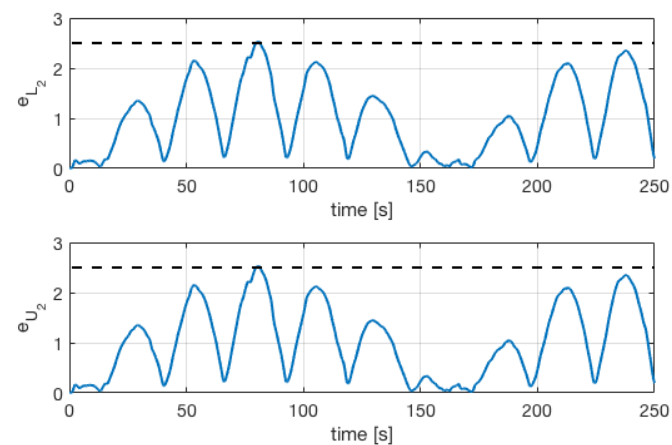
( t ) and e ( t ) for the nominal case H when a random noise is present Figure 8. Residual signals e U L 2 2 on the input reference signal, similar to non-random input (see Figure 3). Again, the programmed threshold is T h = 2.5 (dashed).